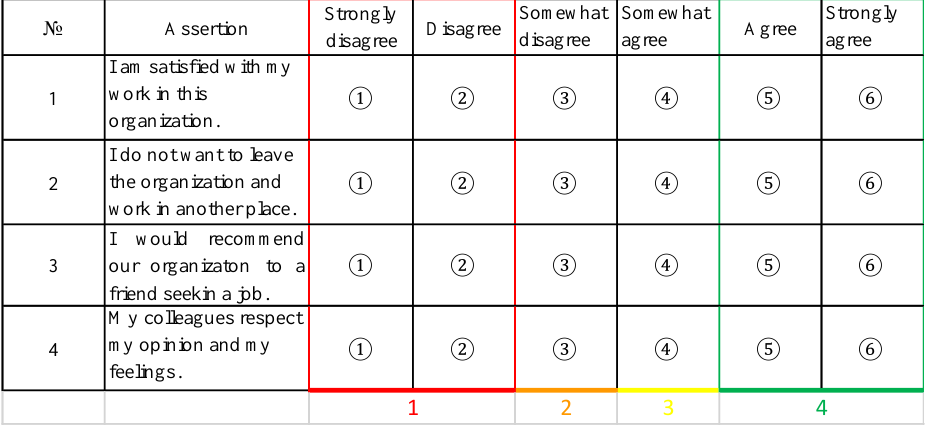
Fig. 4. Values for questionnaire